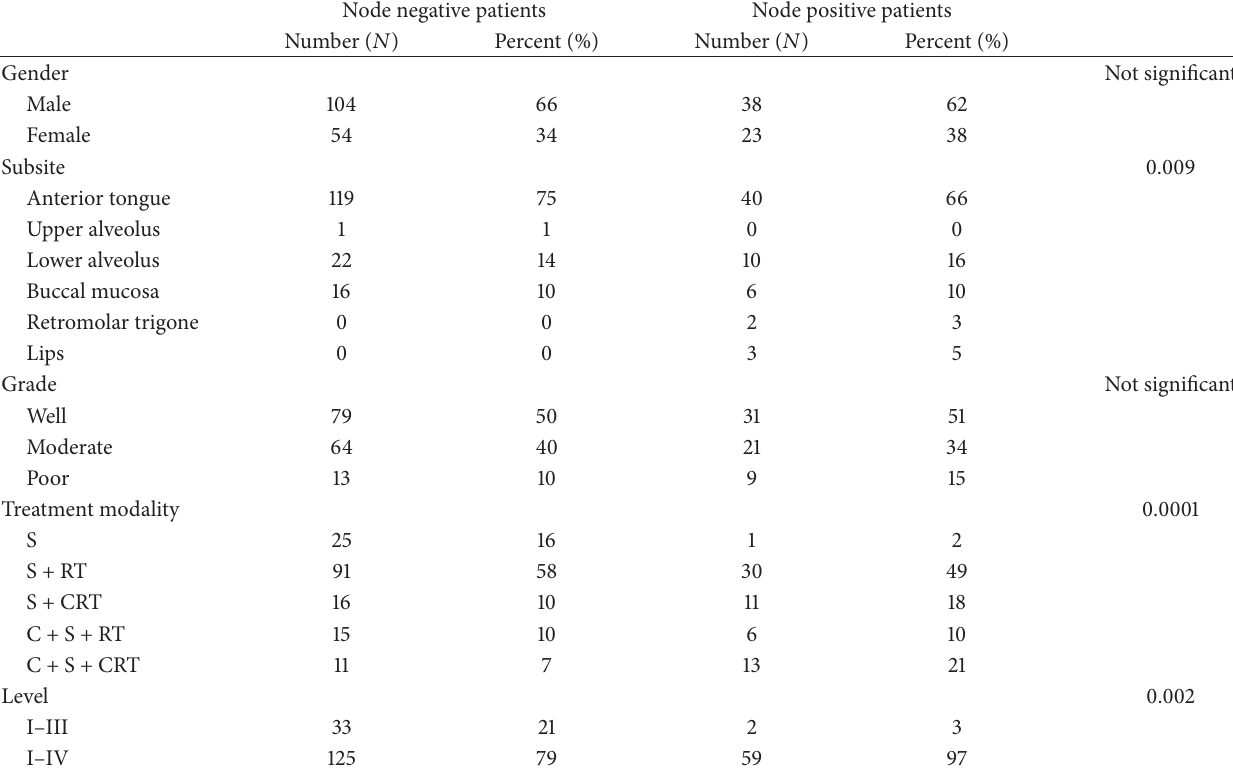
Table 1: Patient characteristics and treatment modalities in clinically node negative and positive patients. Node negative